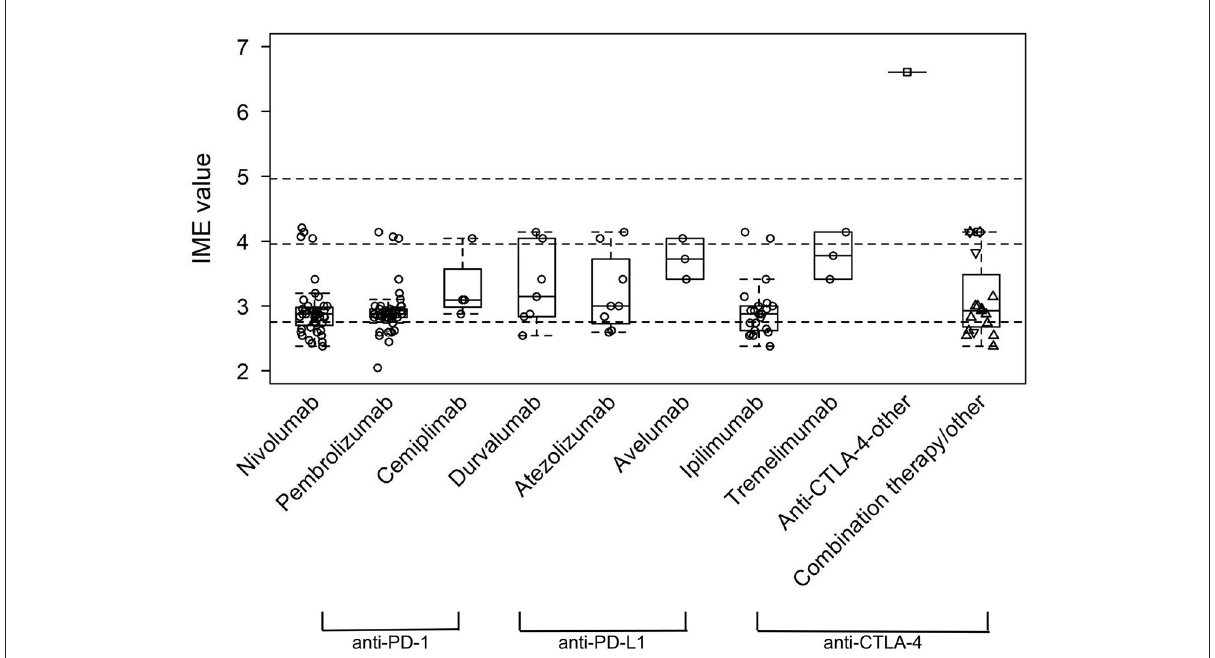
FIGURE6 Integrated metric of evidence (IME) values for specific ICIs. The median IME values were 2.88, 2.88, 3.10, 3.00, 3.14, 3.00, 3.73, 2.88, and 3.78 for nivolumab, pembrolizumab, cemiplimab, toripalimab, durvalumab, atezolizumab, avelumab, ipilimumab, and tremelimumab, respectively. For combination therapy/other, other single-agent is represented by a square, nivolumab + ipilimumab by an up-pointing triangle, durvalumab + tremelimumab by a diamond, and other/non-specified combination by a down-pointing